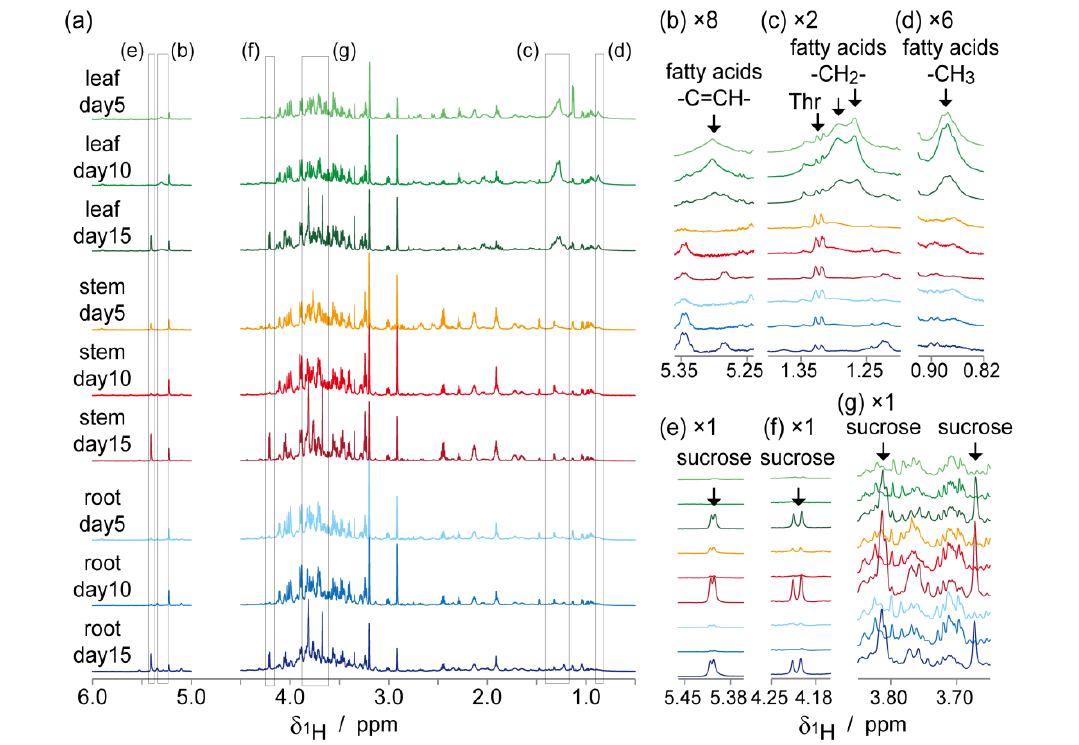
Figure 3. NMR analysis of water-soluble metabolites in different tissues of Jatropha curcas seedlings (2R09). ( a ) 1 H-1D NMR spectra of leaves, stems, and roots harvested 5, 10,